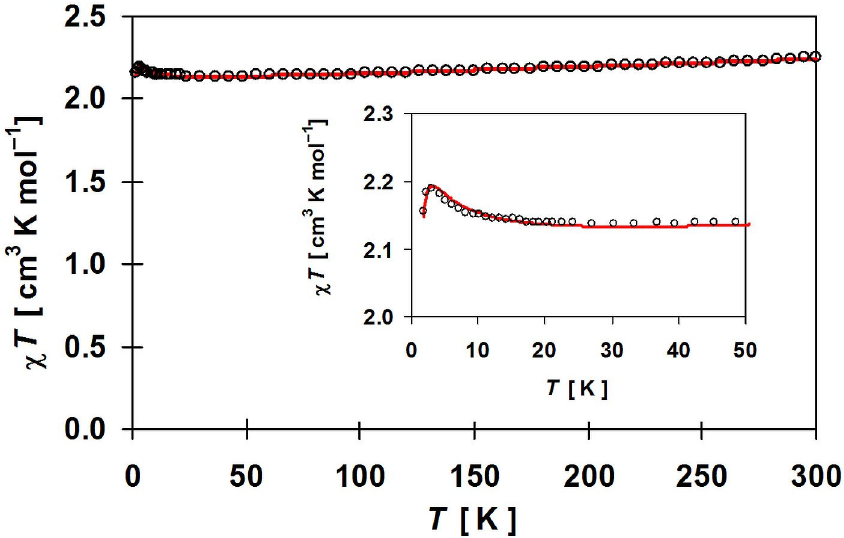
Figure 10. Thermal dependence of χ M T product for [{Cu(pn) 2 } 2 Ni(NCS) 6 ] n · 2nH 2 O ( 1 ). Inset—the low-temperature range. The solid red line is the best fit for the model described in the text. The magnetization curve at 1.8 K (Figure 11) shows no hysteresis loop. Magnetization at saturation equal 4.15 B.M. at 7 T corresponds to the ground state of metal ions with the total spin equal 2 for the {NiCu 2 } unit.